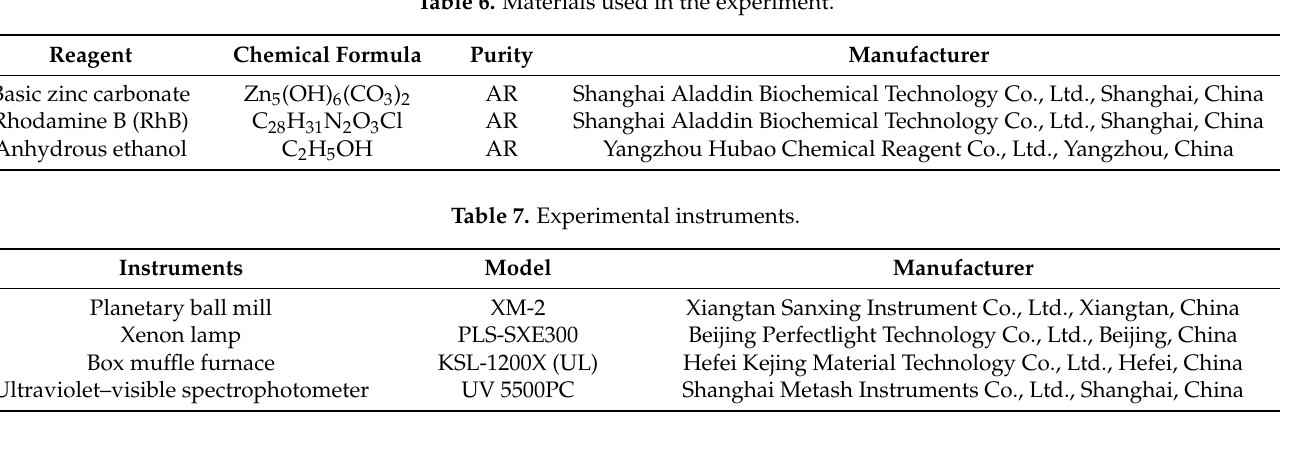
Table 6. Materials used in the experiment.